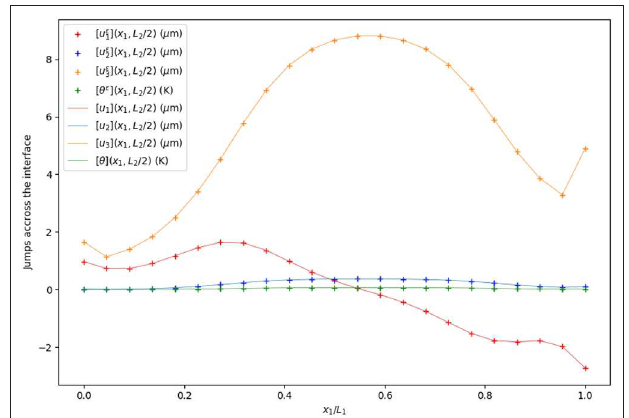
FIGURE 17 | Jumps of the displacement field, temperature (left) , traction vector, and thermal flux (right) across the interface on a line along the x 1 axis, with ε/ h =